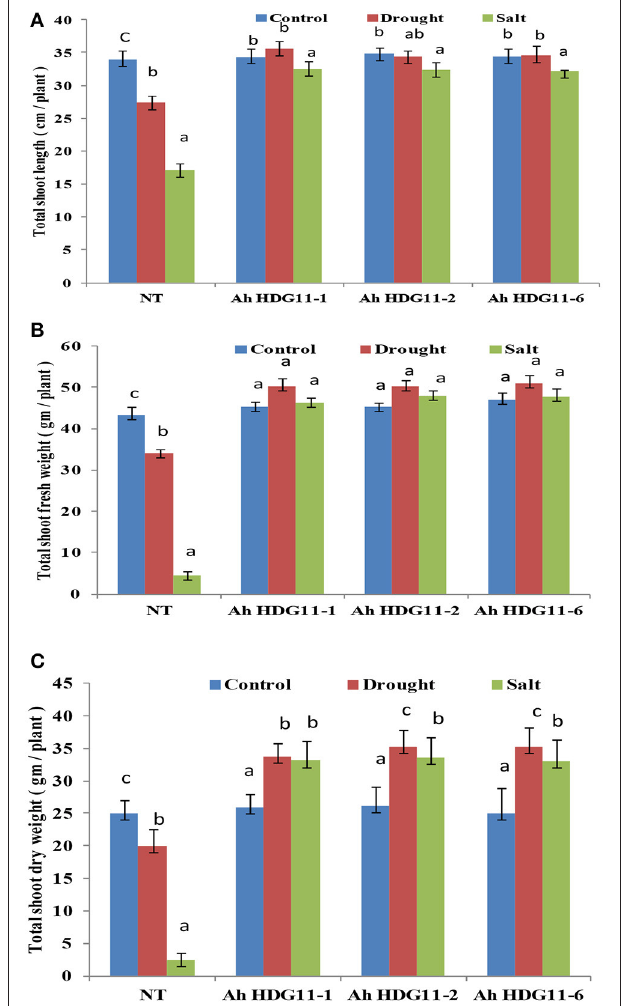
FIGURE 2 | Post-harvest shoot growth and biomass analysis of three transgenic lines AhHDG11-1, AhHDG11-2, AhHDG11-6 along with the control untransformed parent JL-24 (NT) under control (well-watered), drought and salt stress from the confined outdoor lysimetric experiment. (A) Shoot length (cm/plant). (B) Shoot fresh weights (gm/plant). (C) Shoot dry weights (gm/plant). Alphabets in lowercase indicates the statistical significance in differences between WT and transgenics at p <